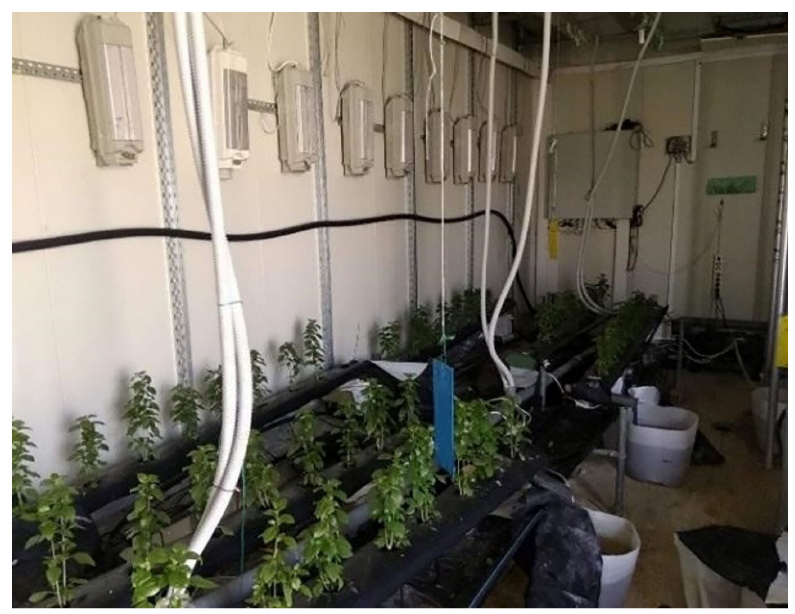
Figure 1. Basil crop cultivated in the NFT system within the closed automatic growth